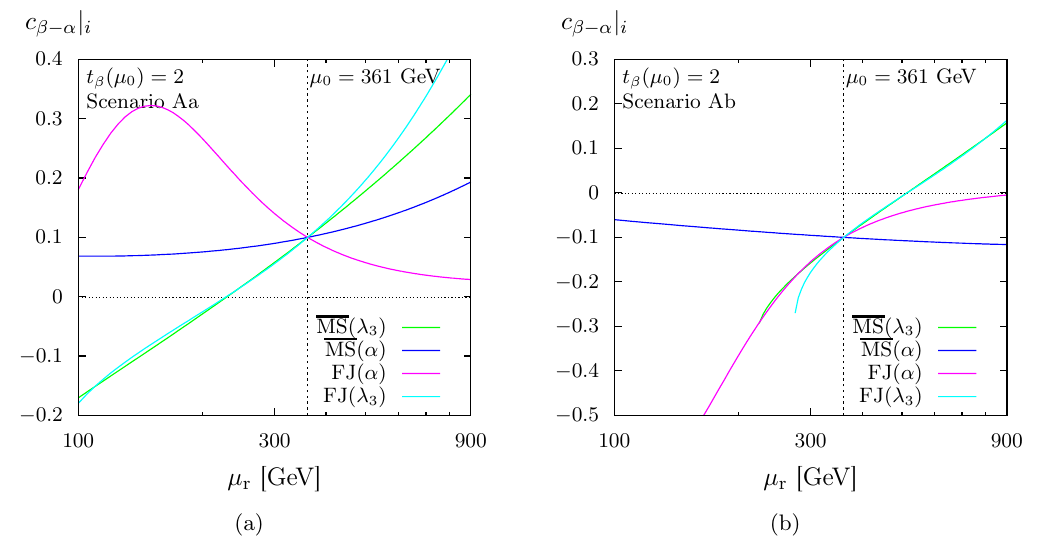
Figure 5 . The running of c (cid:12) (cid:0) (cid:11) for the low-mass scenario A with c (cid:12) (cid:0) (cid:11) = 0 : 1 (a) and c (cid:12) (cid:0) (cid:11) = 0 : 1 (cid:0) (b) in the MS( (cid:11) ) (blue), MS( (cid:21) 3 ) (green), FJ( (cid:11) ) (pink), and FJ( (cid:21) 3 ) (turquoise) schemes. of the scalar self-couplings has a signi(cid:12)cant impact on the running of our MS parameters. The renormalization-group (cid:13)ow in other schemes was, e.g., investigated in refs. [50, 75{78]. The scale dependence of c (cid:12) (cid:11) for (cid:22) = 100 (cid:0) 900 GeV is plotted in (cid:12)gure 5, for the (cid:0) scenario de(cid:12)ned in eq. (4.65) with c (cid:12) (cid:11) = 0 : 1 (l.h.s) and c (cid:12) (cid:11) = (cid:0) 0 : 1 (r.h.s) and input (cid:0) (cid:0) values given at the central scale (cid:22) 0 stated in eq.